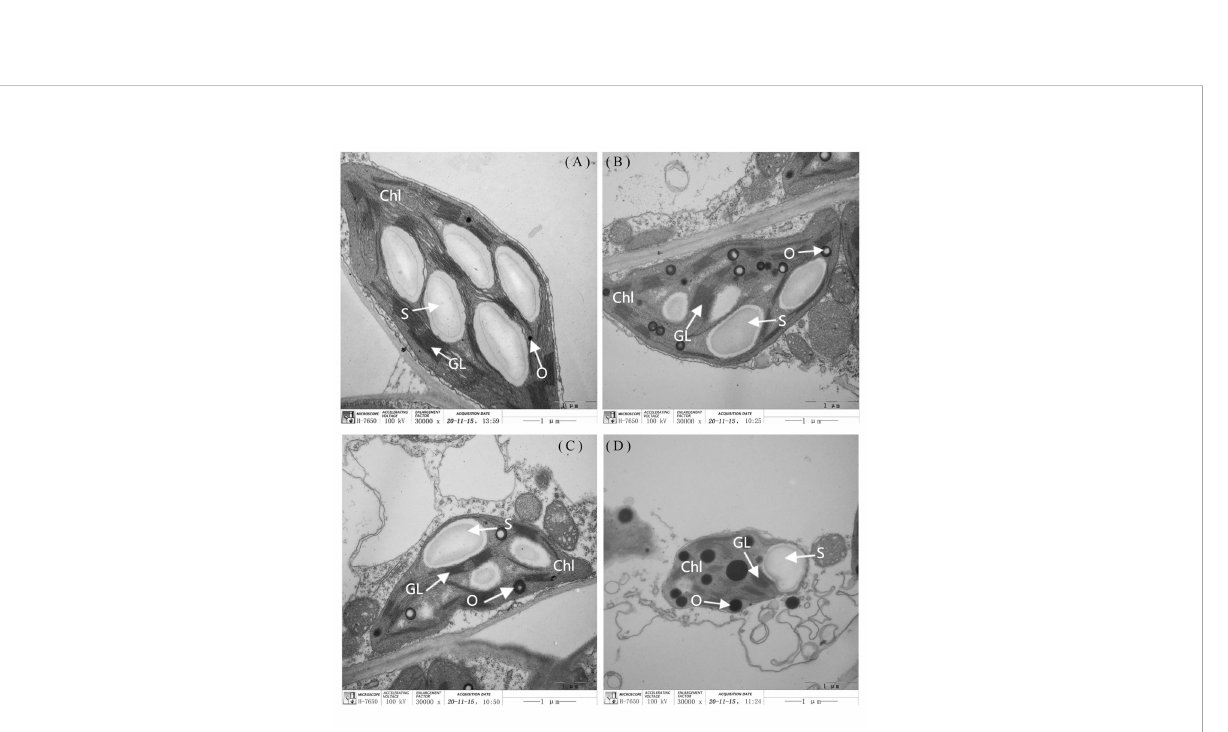
FIGURE 5 The ultra-structure of leaf chloroplast observation in different cucumber lines. The (A) and (C) are each representing the mincrostructure of chloroplast (×30000) in M67 and M14 under normal light, the (B) and (D) are each representing the mincrostructure of chloroplast (×30000) in M67 and M14 in low light treatment. Chl, Chloroplast; S, Starch; GL, Grana lamella; O, Osmiophilic